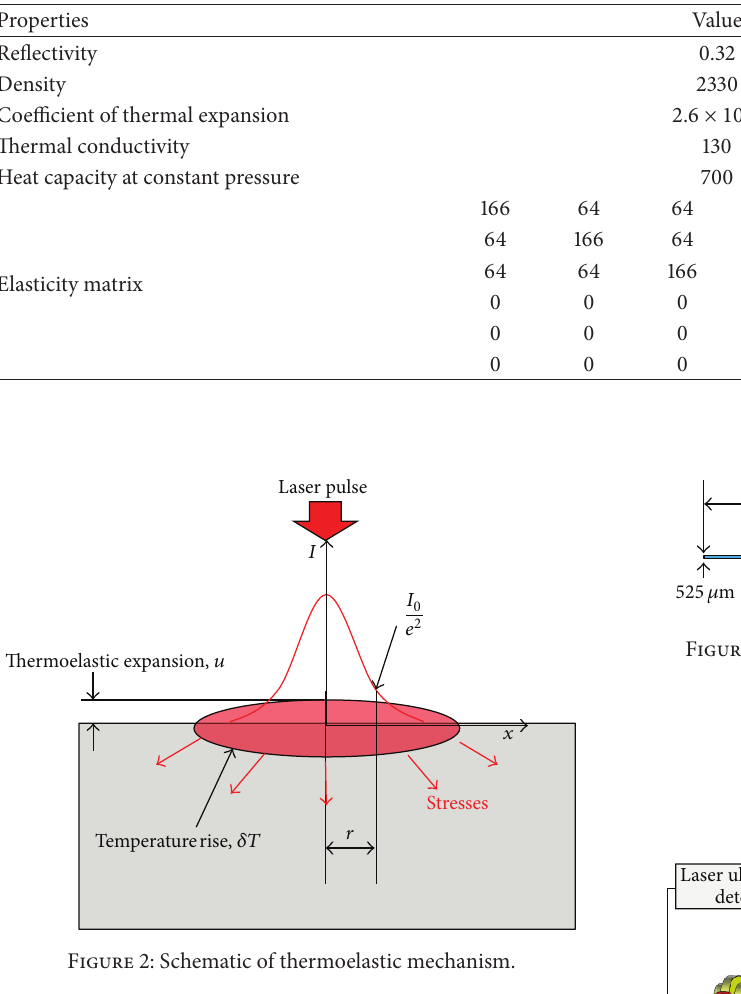
Table 2: Properties of the wafer.